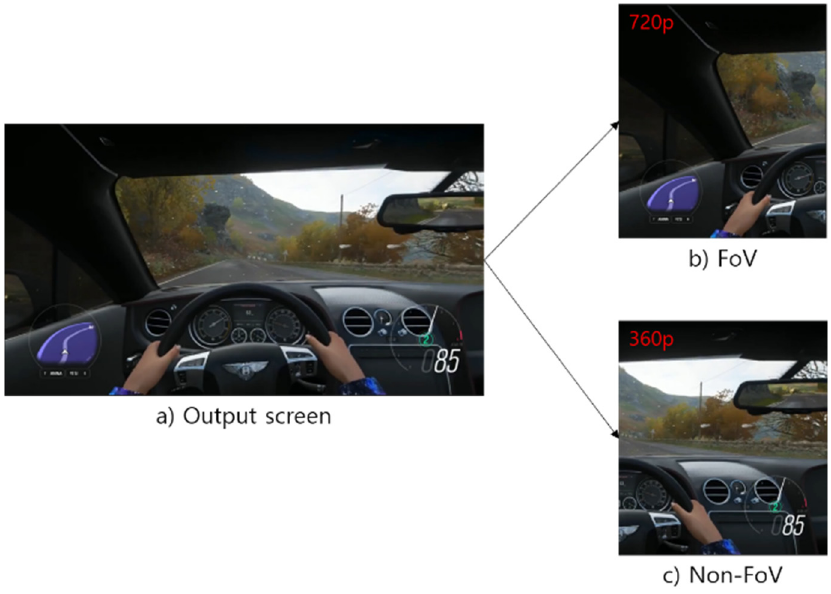
The server prepares video for output through preprocessing.